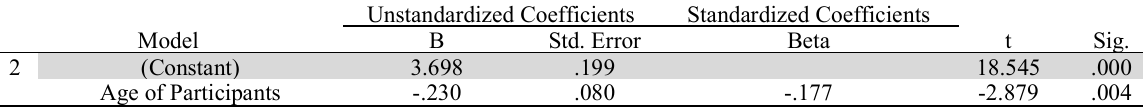
JS against Age – Analysis of Coefficients